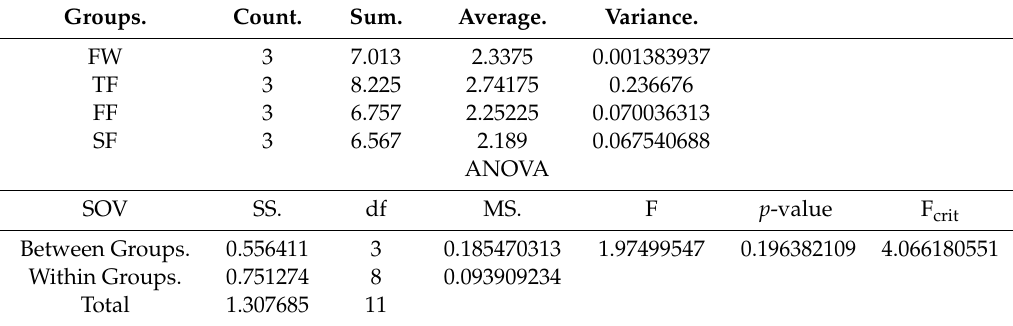
Table 9. Results of ANOVA test for CIM of RAGC mixes made with di ff erent types of e ffl uent at 90-days. Groups. Count. Sum. Average. Variance. FW 3 19.1604 6.3868 26.7624 SF 3 20.1768 ANOVA SOV SS. df MS. F. p -value. F crit Between Groups. 11.77319 3 3.92439824 0.0884 4.066180551 Within Groups. 10.0826